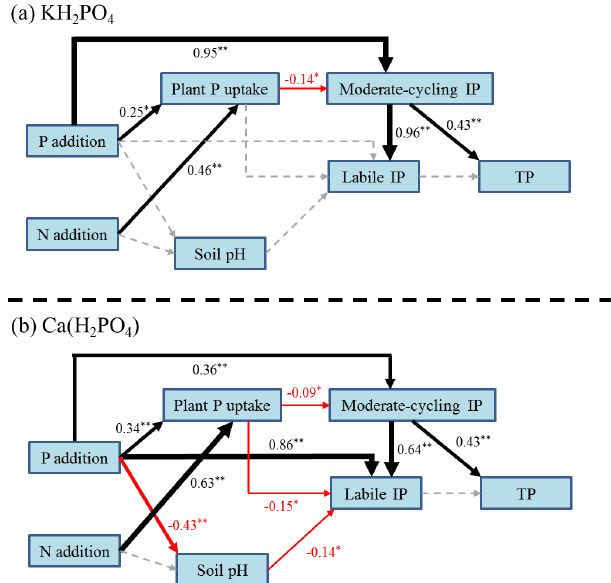
Figure 6. Structural equation model of the relationships between soil pH, plant P uptake, soil moderate-cycling inorganic phospho- rus (IP), labile P, and TP under KH 2 PO 4 ( a , χ 2 = 23 . 44, P = 0 . 38, RMSEA = 0.03, AIC = 67.44) and Ca ( H 2 PO 4 ) 2 additions ( b , χ 2 = 27 . 01, P = 0 . 08, RMSEA = 0.09, AIC = 79.01) across N treat- ments. Arrows indicate positive (black), negative (red) and neutral (dotted grey) effects. Arrow width is proportional to the strength of the relationship. The number adjacent to each arrow is the stan- dardized path coefficient with corresponding significance ( ∗ , ∗∗ for P < 0 . 05 and 0.01, respectively).